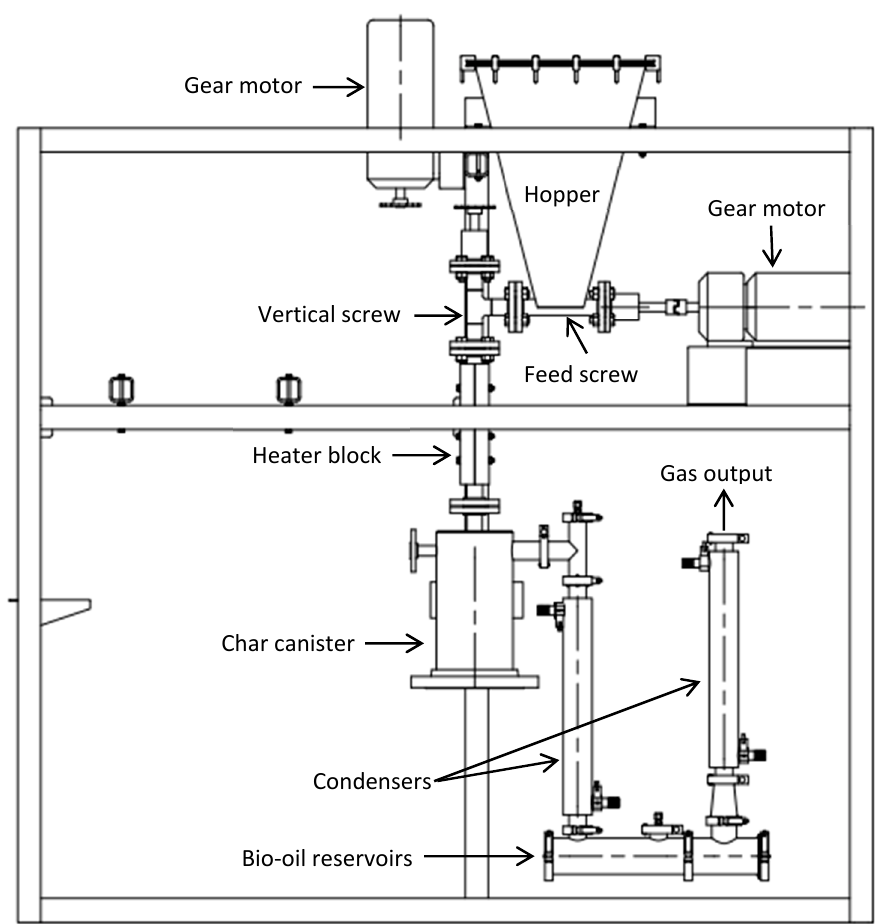
Figure 1. Schematic view of the vertical auger pyrolysis reactor.